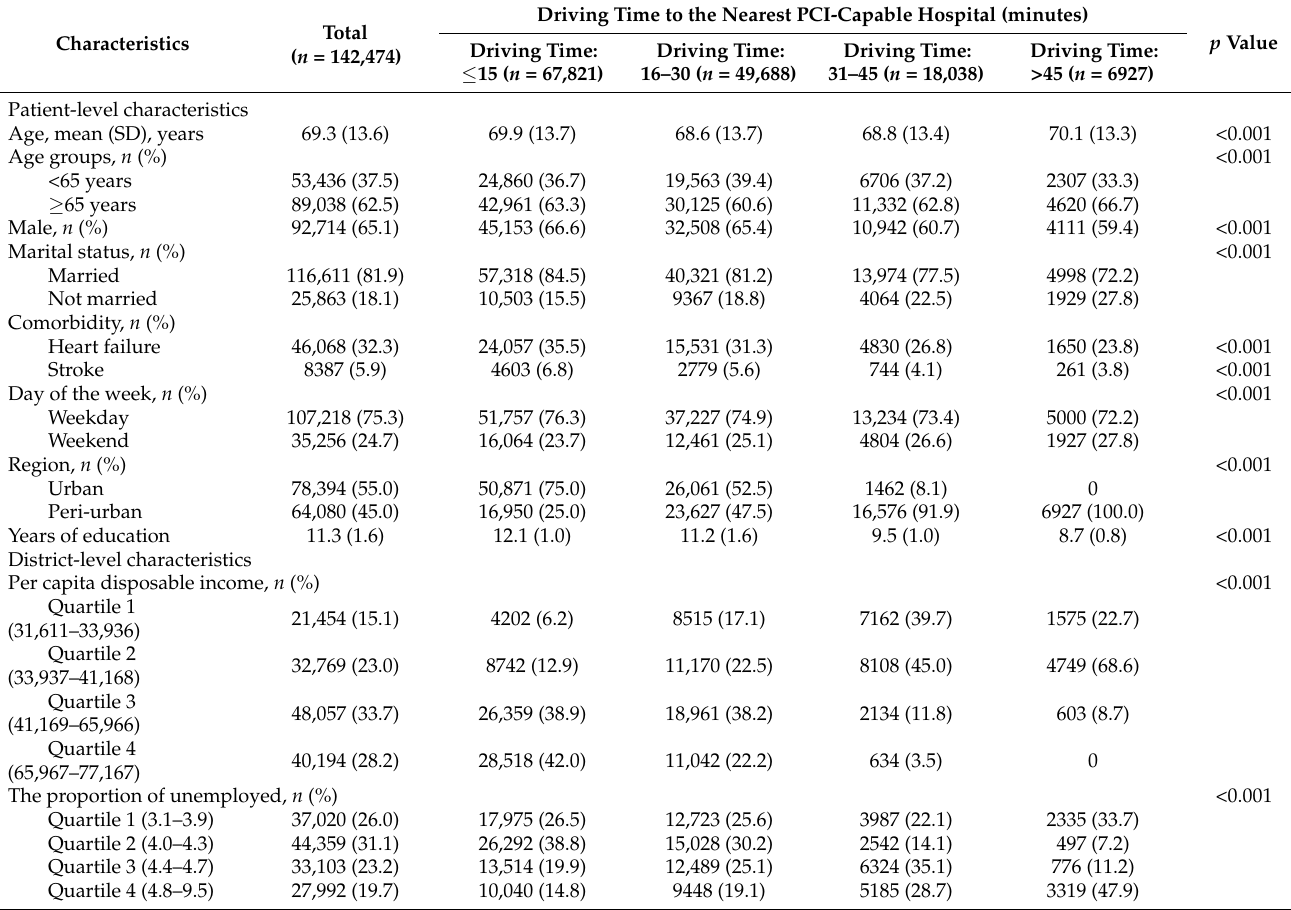
Table 1. Characteristics of patients with acute myocardial infarction in Beijing between 2013 and 2019.